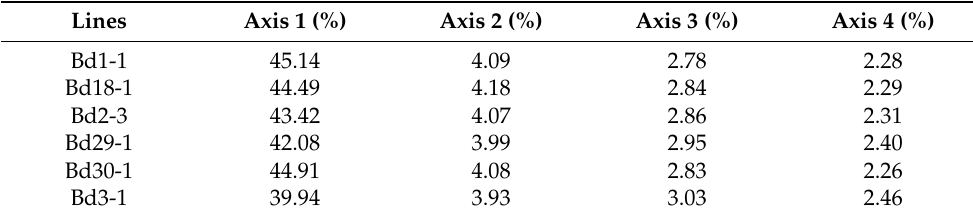
Table 2. The main variances of the four axes of the six lines.